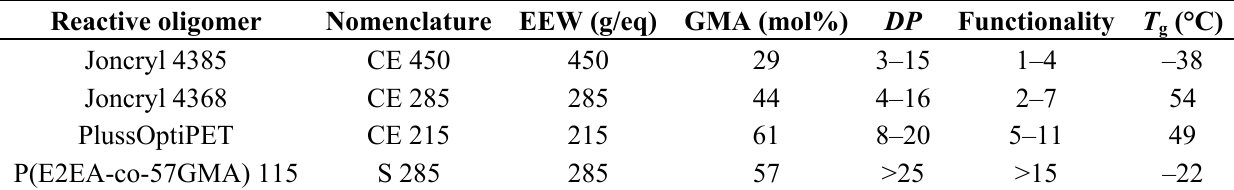
Table 4. List of varying functionality reactive oligomers